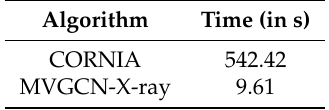
Table 8. The time complexity comparison between CORNIA and MVGCN-X-ray to extract features from an X-ray image of size 6329 × 5380 on a 4-GHz quad-core processor with 32 GBs of